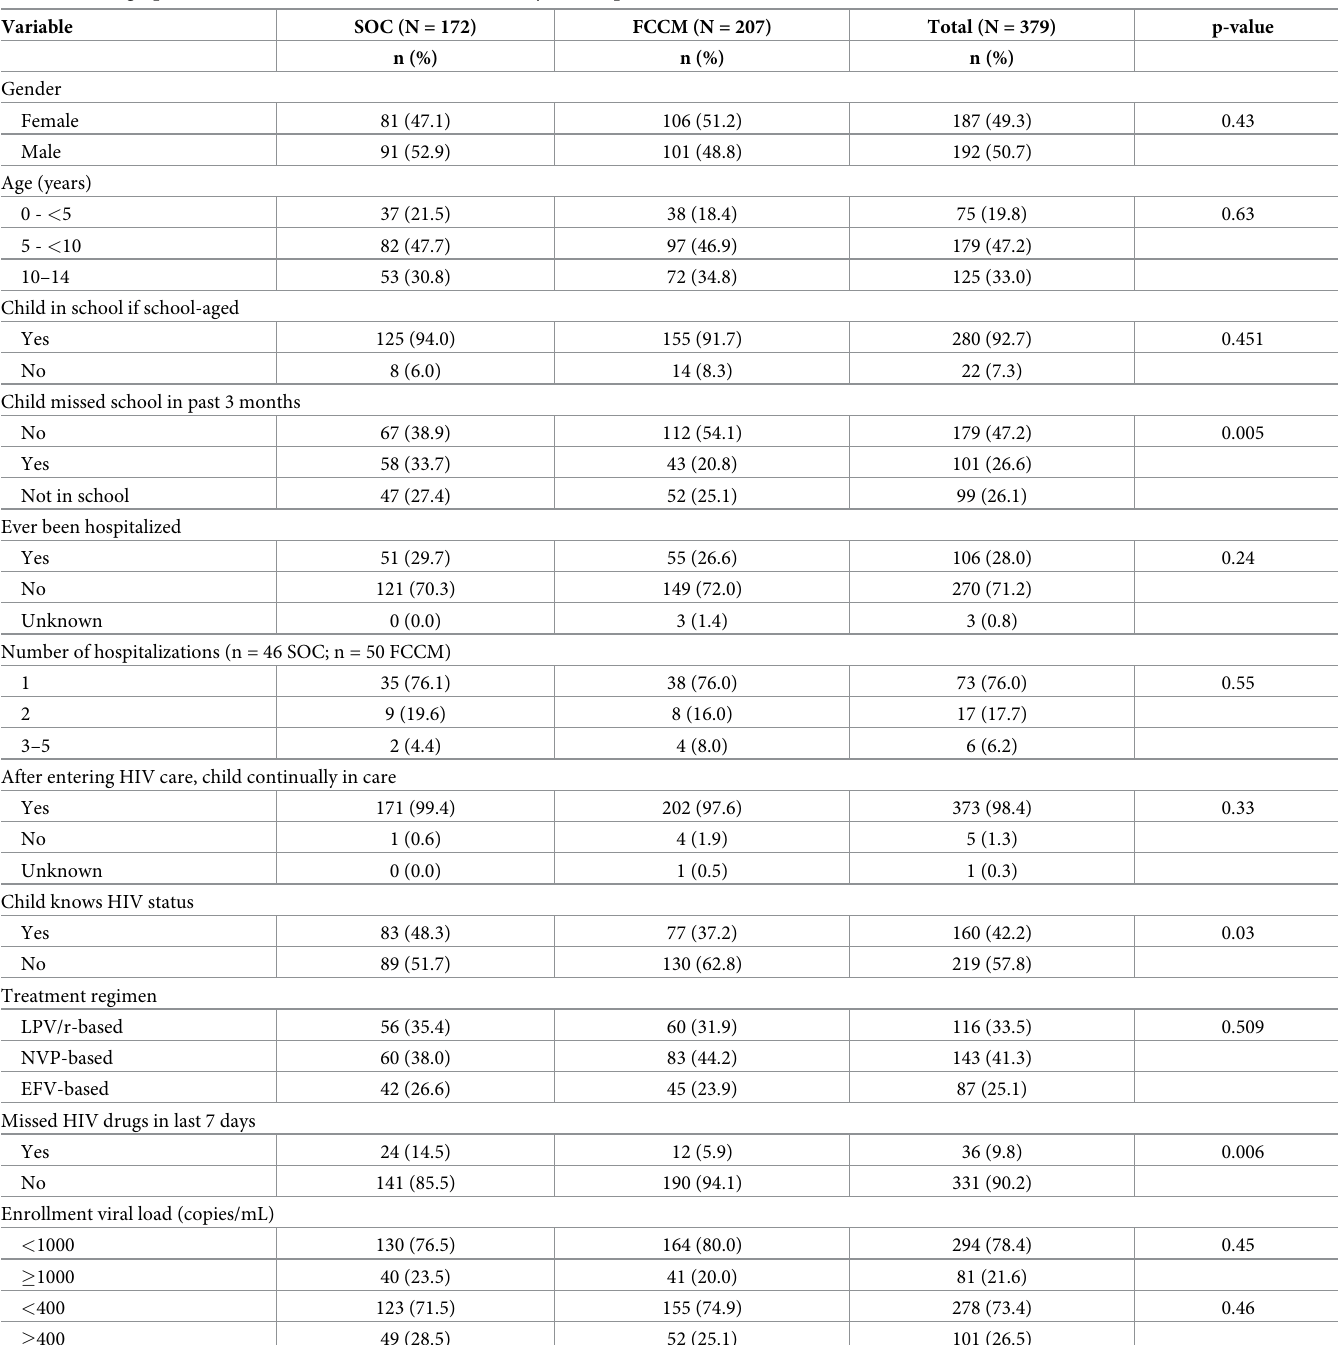
Table 1. Demographic characteristics, HIV and treatment history of HIV-positive